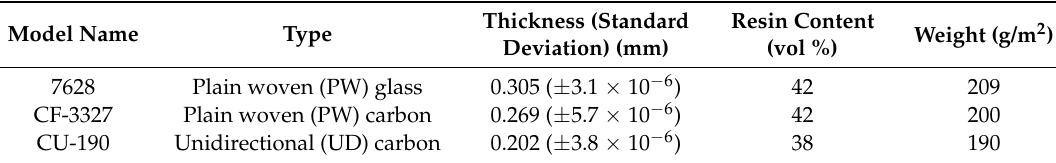
Table 1. Physical properties of the different types of prepreg.